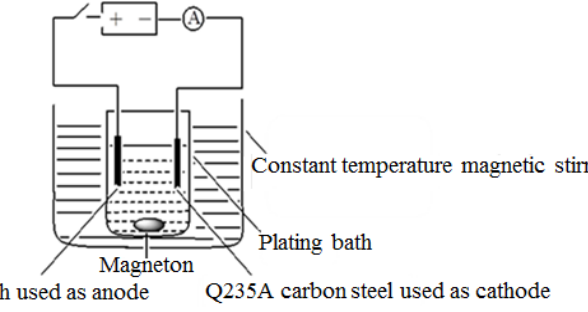
Figure 2. Schematic diagram of the DC electrochemical deposition device .